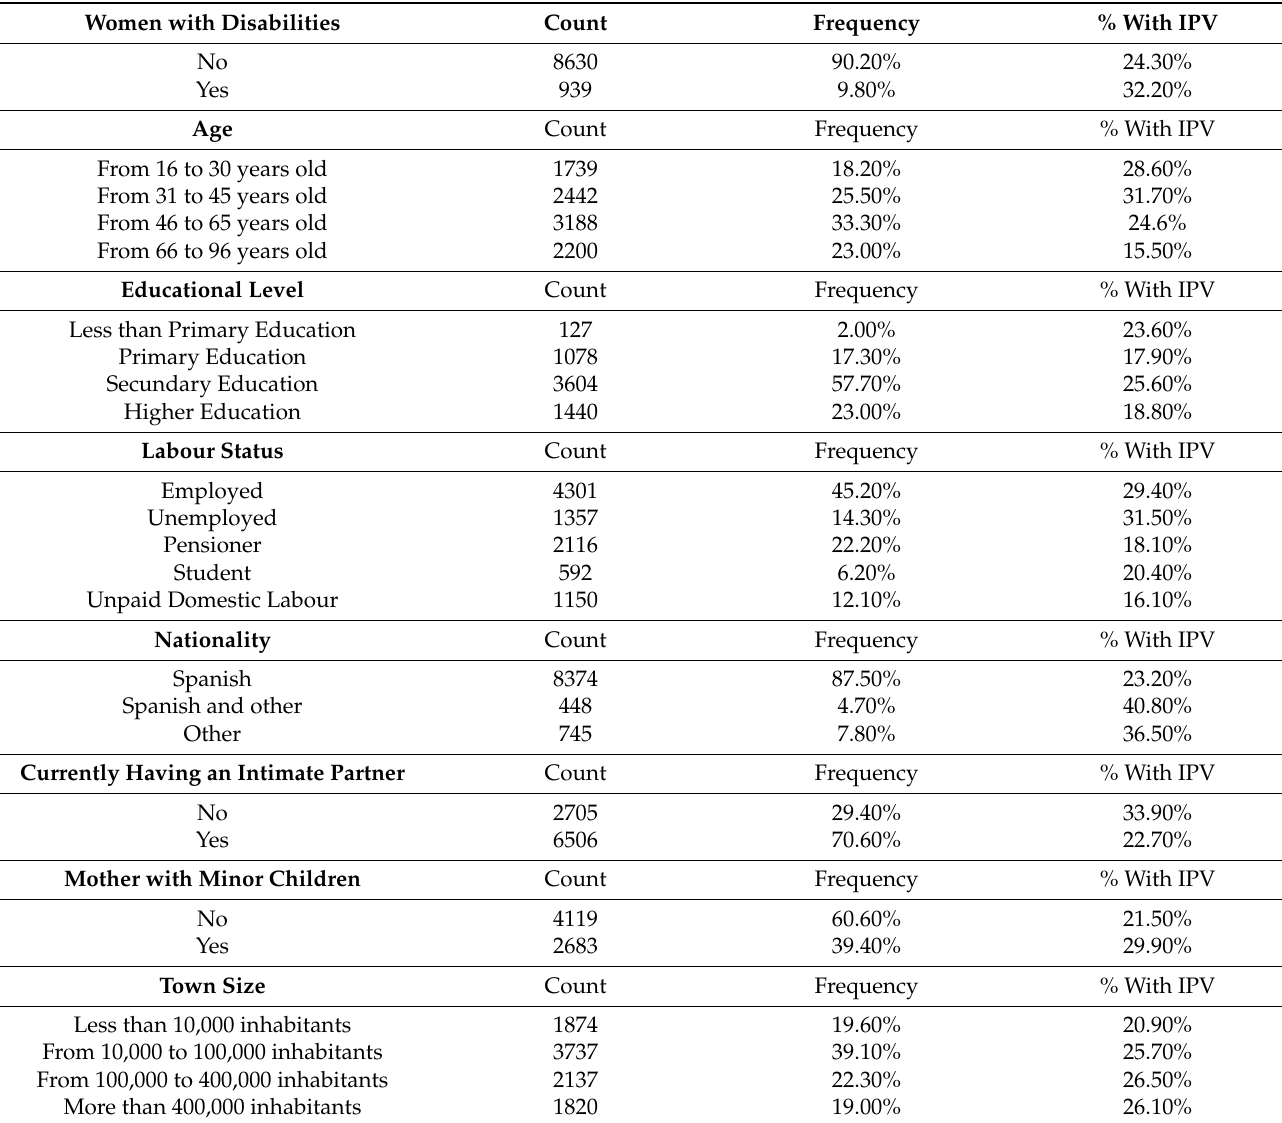
Table 1. Sociodemographic characteristics: Count, frequency, and percentage of women with Intimate Partner Violence